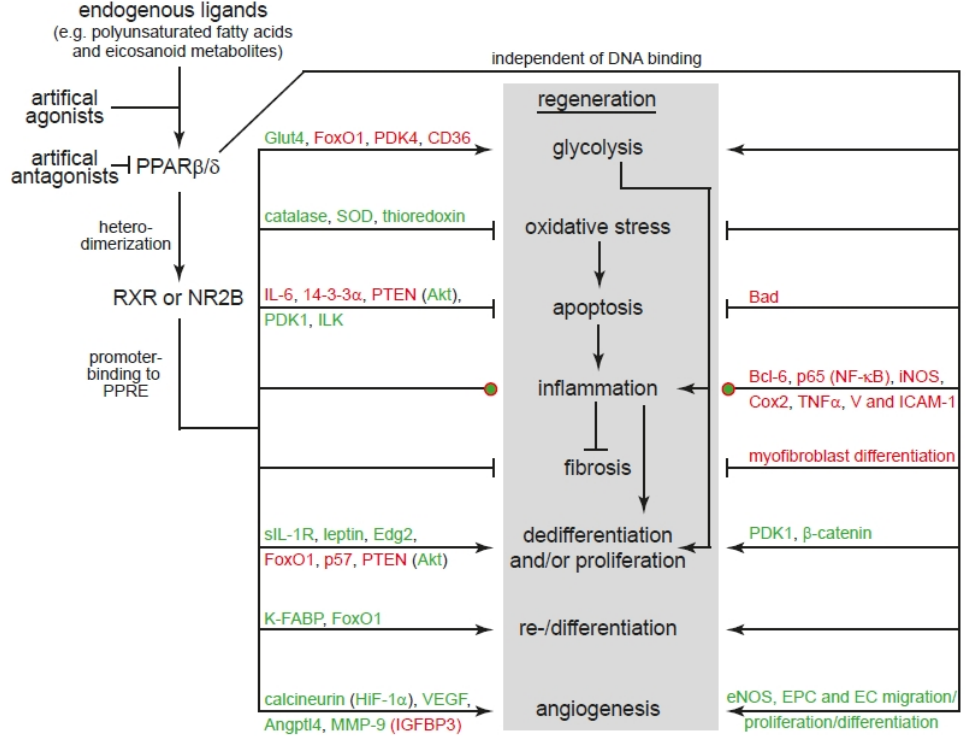
Figure 1. Examples of direct targets of PPAR β / δ involved in the different processes of regeneration. Red: inactivation. Green: activation. Affected pathways are indicated in brackets. Note: inflammation needs first to be activated and later inhibited during regeneration.